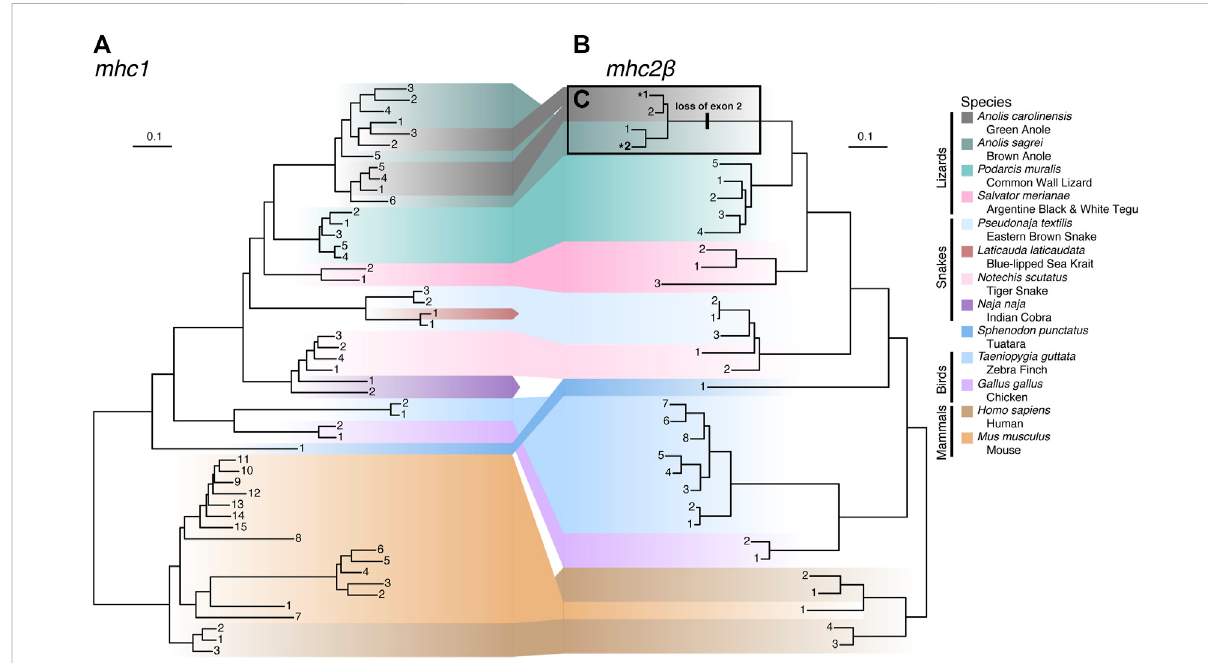
FIGURE 8 Phylogenies of (A) mhc1 and (B) mhc2 β homologs from 13 amniote species. Gene homologs are labeled with sequential numbers for each species. See Supplementary Table S13 for associations between sequential numbers and annotation gene IDs for each species and gene. (C) Anole homologsof mhc2 β lackingexon2areindicatedwithboldingandanasterisk(*)andthebranchwherethelossofthisexonputativelyoccurredisalso